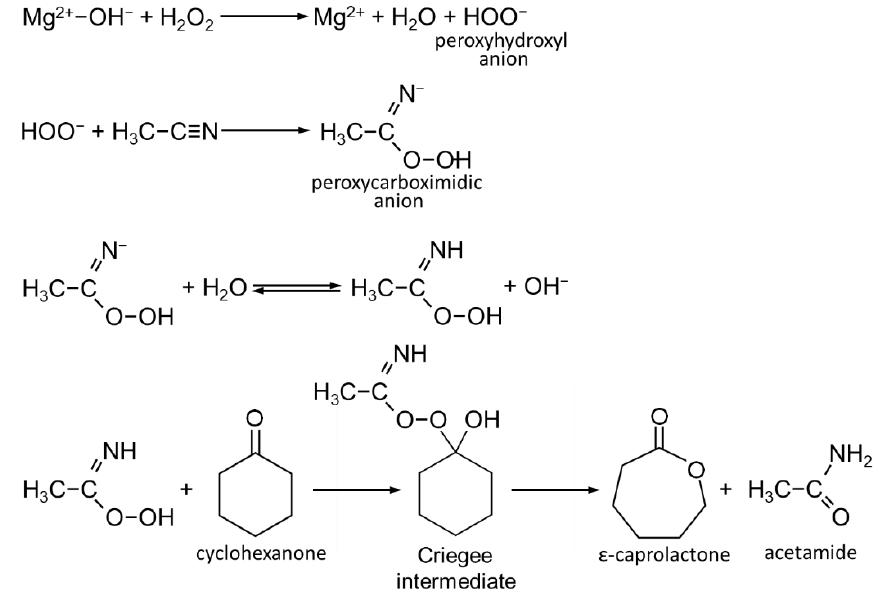
Figure 6. Schematic illustration of reaction steps involved in the oxidation of cyclohexanone to ε -caprolactone with H 2 O 2 /acetonitrile system of Mg-Al HT catalysts. Reaction conditions: 0.125 g of catalyst, 12.5 mmol of cyclohexanone, 100 mmol of 30% H 2 O 2 , 200 mmol of acetonitrile, time = 3 h, temperature = 70 °C, batch reactor.